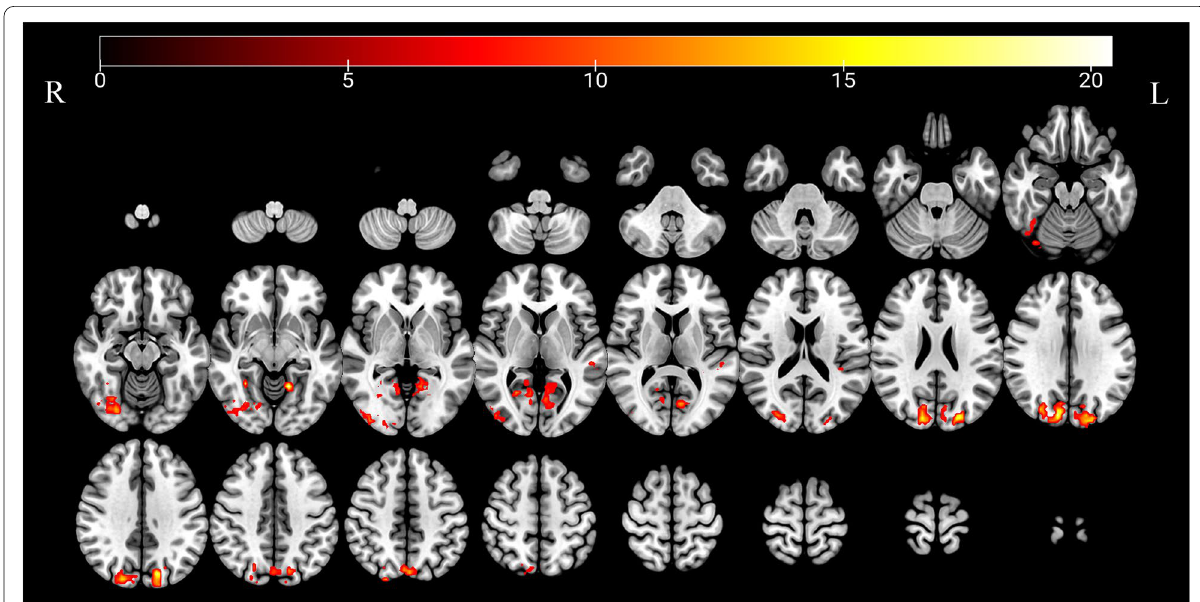
Fig. 4 Significant differences in dALFF among different times after triggering the pain in patients with CTN. dALFF, Dynamic amplitude of low-frequency fluctuation; CTN, classical trigeminal